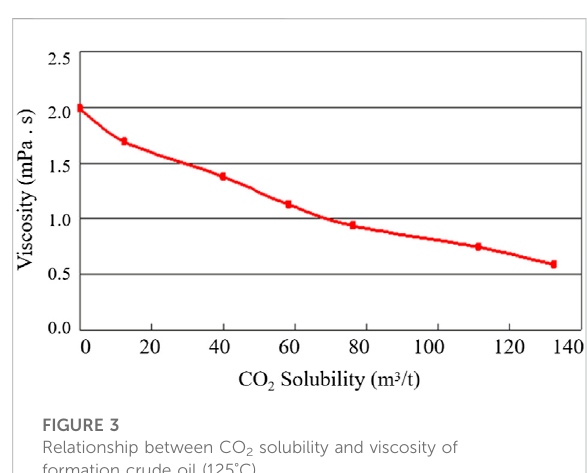
FIGURE 3 Relationship between CO 2 solubility and viscosity of formation crude oil (125 °